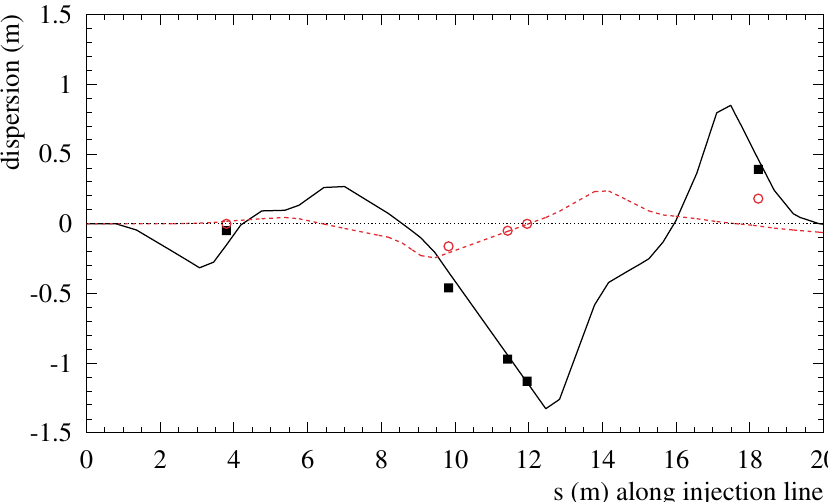
FIG. 12. (Color) Dispersion measurements in the injection line. The full squares are the experimental points in the horizontal plane and the solid curve is given by the model for the corresponding current settings. The open circles and the dashed line are measurements and expectations from the MAD model in the vertical plane, respectively.